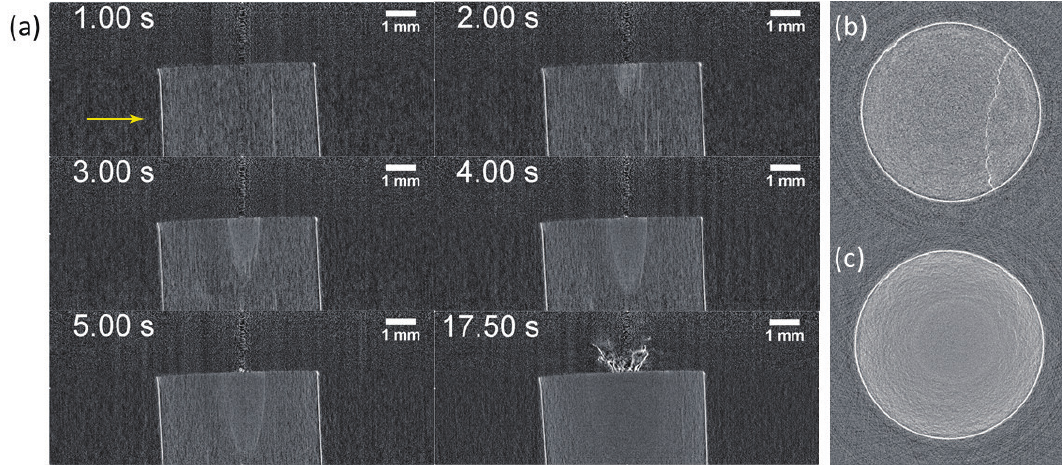
Figure 7. Tomographic reconstruction from visibility reduction for a carbon fiber reinforced polymer (CFRP) sample [65]: ( a ) Sagittal section views at different times after starting laser irradiation, and axial section views at ( b ) 1 s and ( c ) 17.5 s on the position indicated by the yellow arrow in ( a